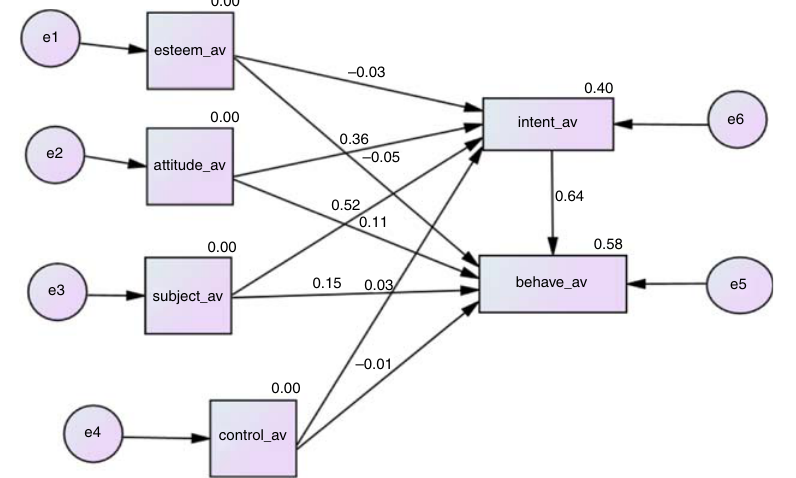
Figure 1. Model of cyberbullying behavior before